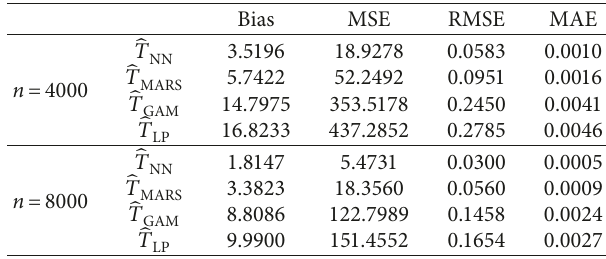
Table 3: UBIAS, UMSE, URMSE, and UMAE for a three-di- mensional mixed